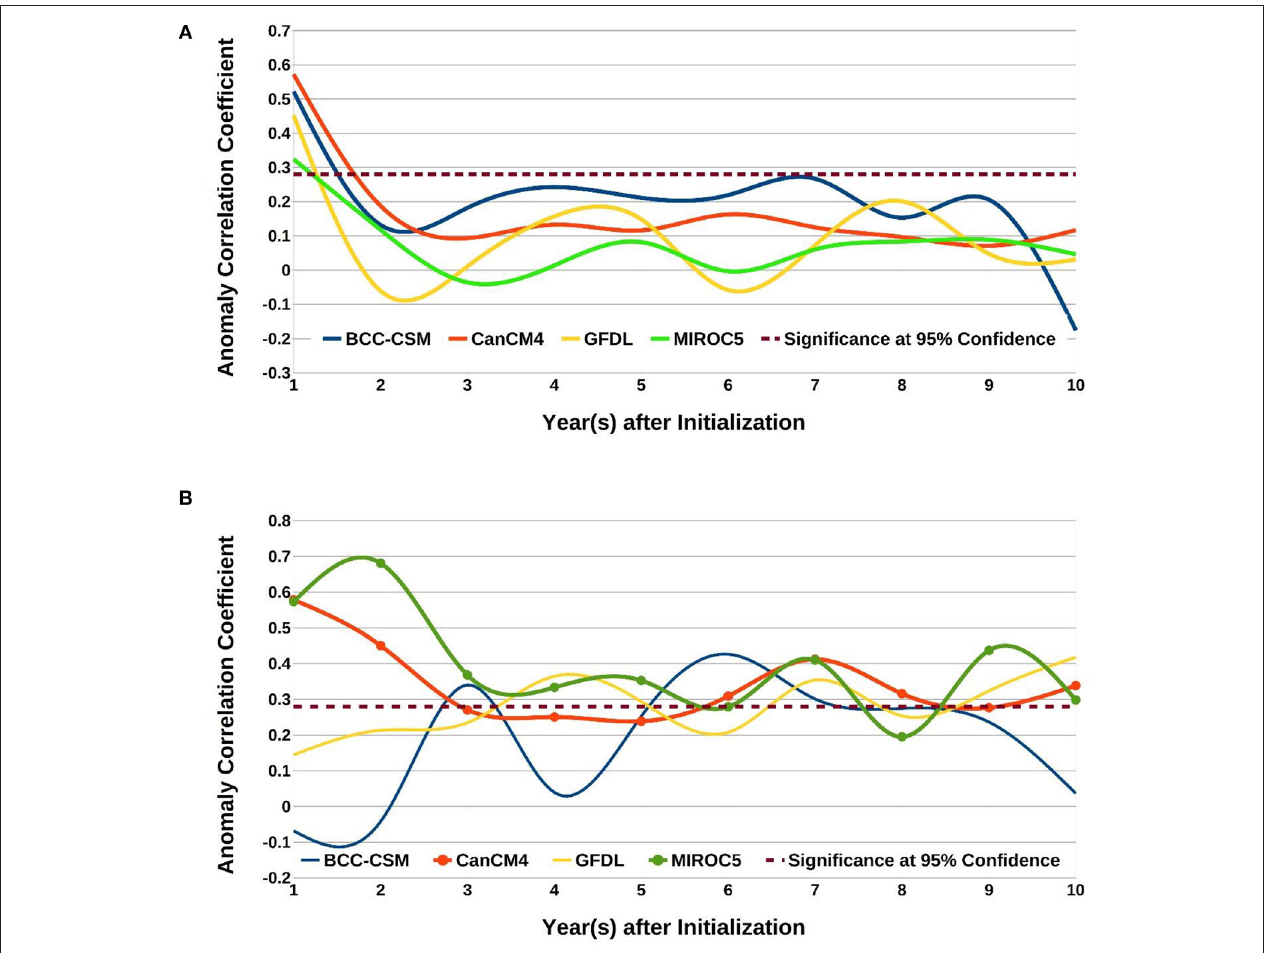
FIGURE 2 | (A) Anomaly correlations between observed NINO3 index with the corresponding predicted NINO3 index at different lead years for various models, shown in different colors. The significant correlation value at 95% confidence level is 0.27 and is shown by dashed lines. Details of how the correlations at different leads were obtained, from the sets of ∼ 51 year-long decadal prediction runs with different initial years, are available from section Statistical Methods and Figure 1 . (B) Same as (A) but for the IODMI. The lines with circles in (B) are the two models of interest for this study.